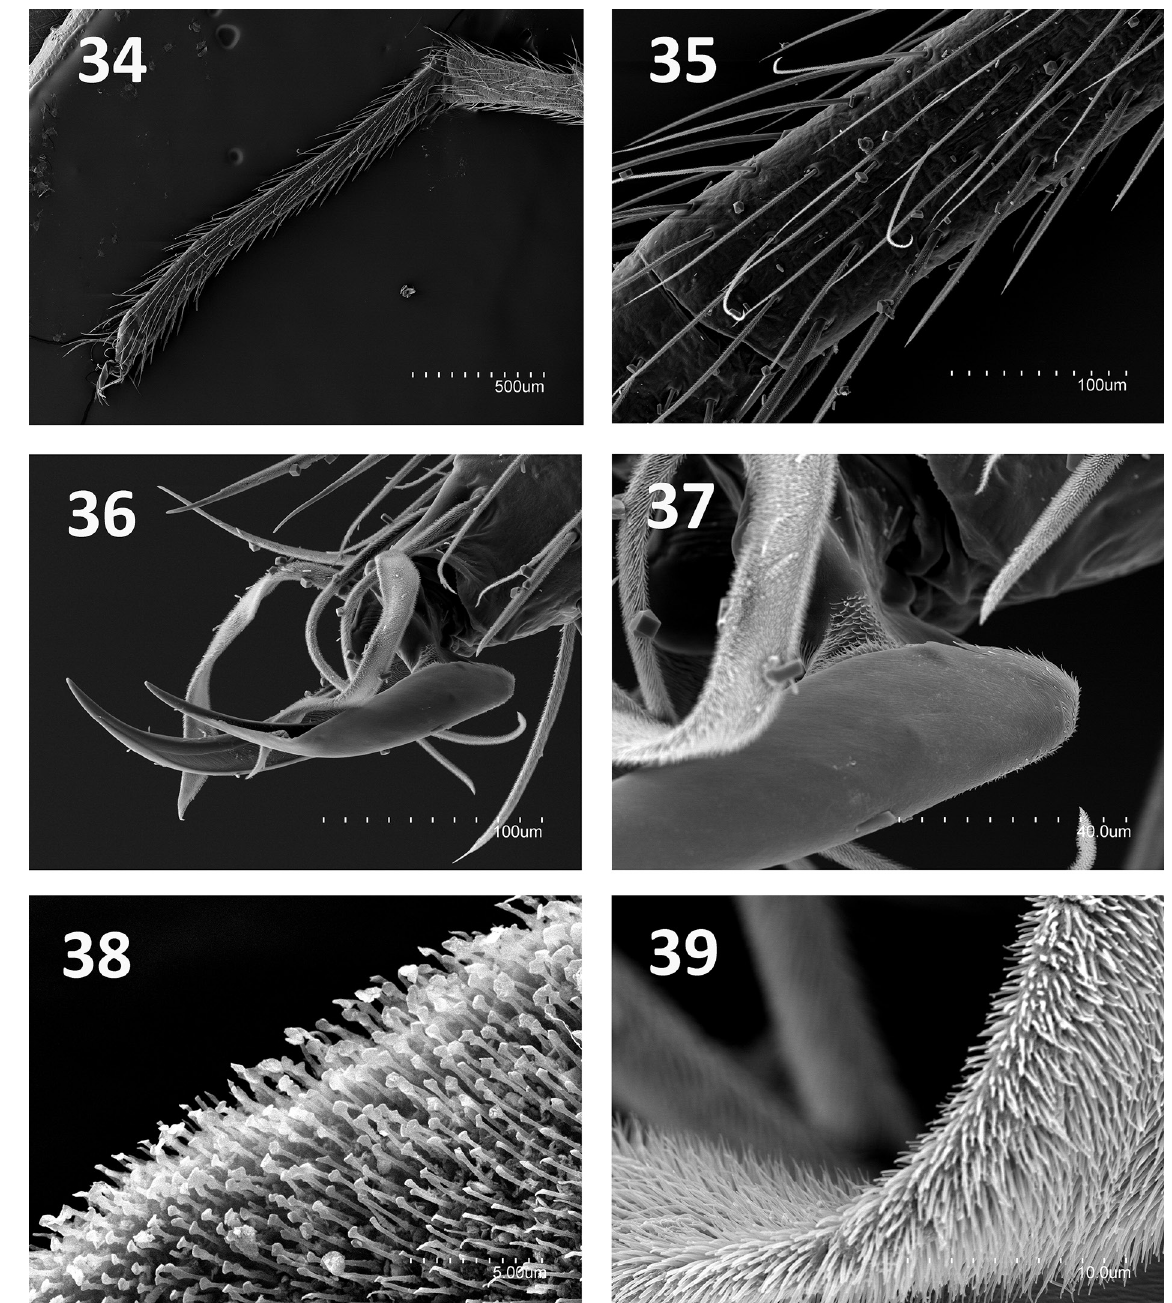
Figs 34‒39. Hubeicampa melissa Sendra & Lips gen. et sp. nov. 34 . Tarsus of metathoracic leg. 35 . Medial portion of tarsus. 36 . Pretarsus. 37 . Detail of the posterior portion of a claw. 38 . Detail of the distal part of a lateral process. 39 . Detail of the lateral part of a lateral